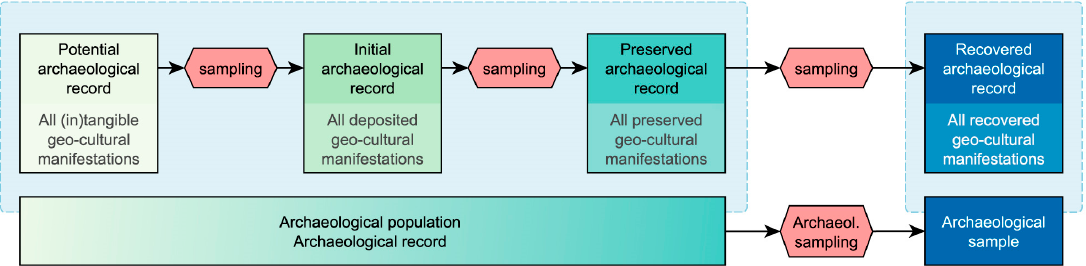
Figure 2. Explanations about the past are based on the deficient and biased archaeological data at our disposal. These data, the archaeological sample (or recovered archaeological record), are only a small subset of all present remains of past human behaviour.